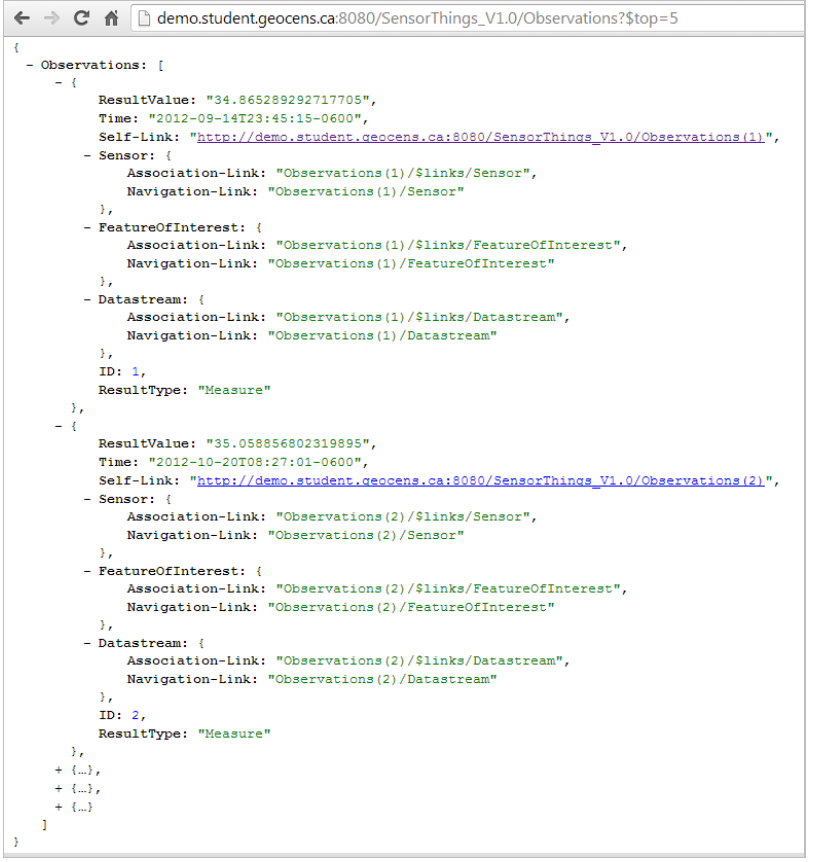
Figure A8. Response of the SensorThings to multiple readings